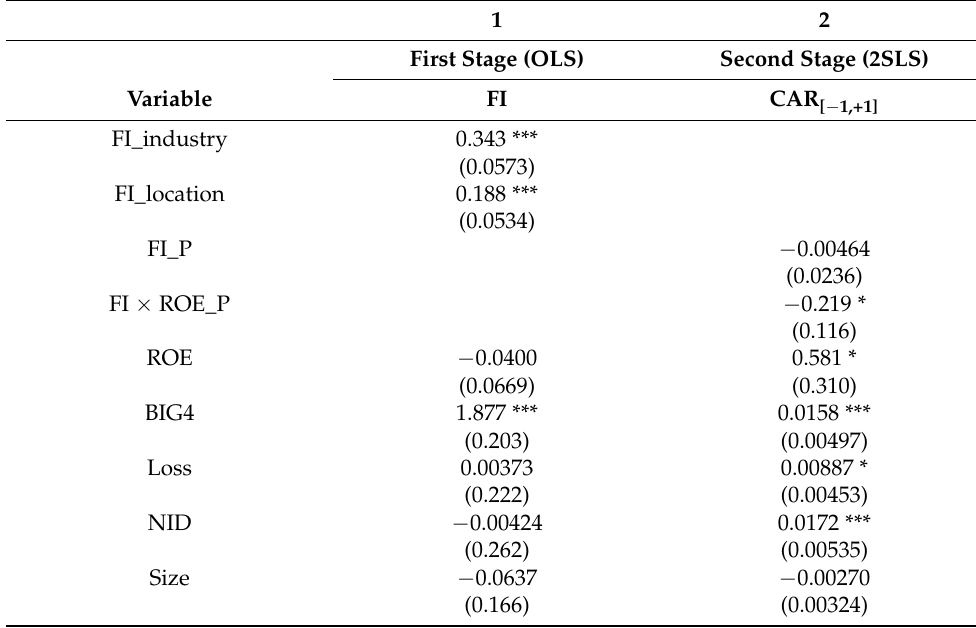
Table 7. Instrumental variable regression test results of readability and